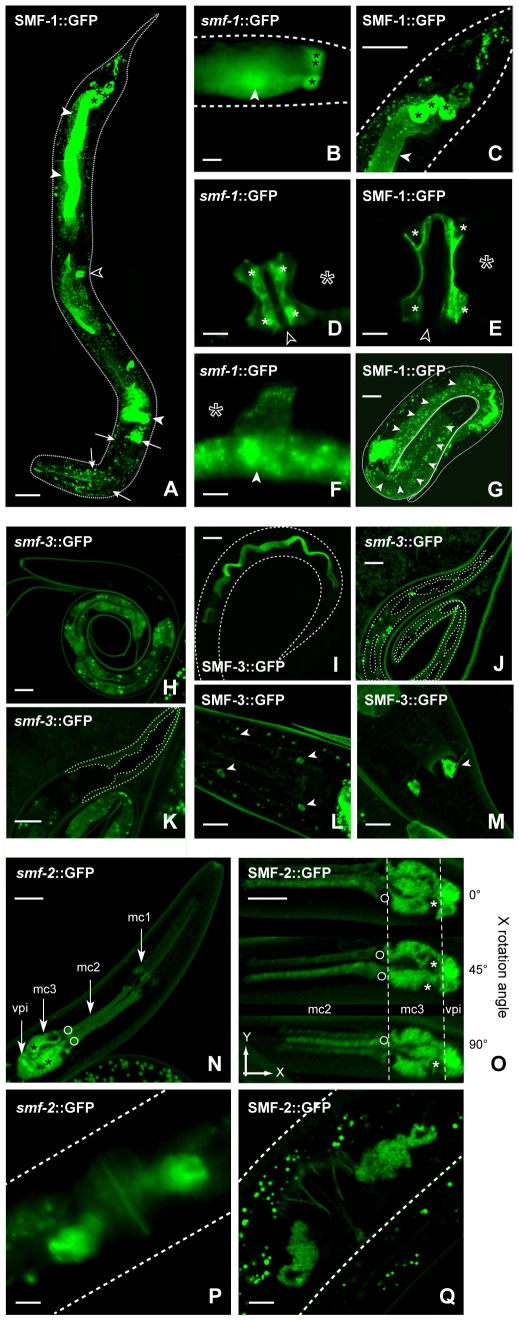
Expression pattern analysis of C. elegans smf genes.A, SMF-1::GFP strongly localizes to the anterior and posterior intestine (solid white arrowheads), to the anchor cell (hollow arrowhead) and to head neurons (white arrows). smf-1::GFP and SMF-1::GFP reveal expression of smf-1 gene in rectal gland cells (B,C, black asterisks), in the uterus (uv1, uv2, utse syncytium, D,E, solid white asterisks) as well as in the adult spermatheca (F) and the L1 hyp7 epidermis (G, white arrowheads). Dotted lines outline the cuticle of the worm. Hollow asterisks indicate position of fertilized embryos. Hollow arrowheads indicate position of the vulva. smf-3 is mainly expressed in the intestine as revealed by smf-3::GFP (H) and SMF-3::GFP (I), in the major epidermis hyp7 (J, dotted line) and head epidermis hyp1-6 (K, dotted line), and in head (L) and tail neurons (M). An antero-posterior gradient of smf-2 expression is noticeable in the 9 marginal epithelial cells of the pharynx (mc1, mc2, mc3) and the 6 vpi cells of the pharyngeo-intestinal valve (N and O). Fainter expression is consistently observed in the proximal gonad (P, Q). Scale bars are 5 µm.